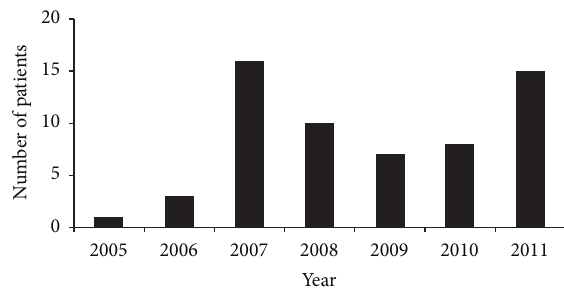
Figure 1: Distribution of the number of decompressive craniec- tomies performed each year between 2005 and